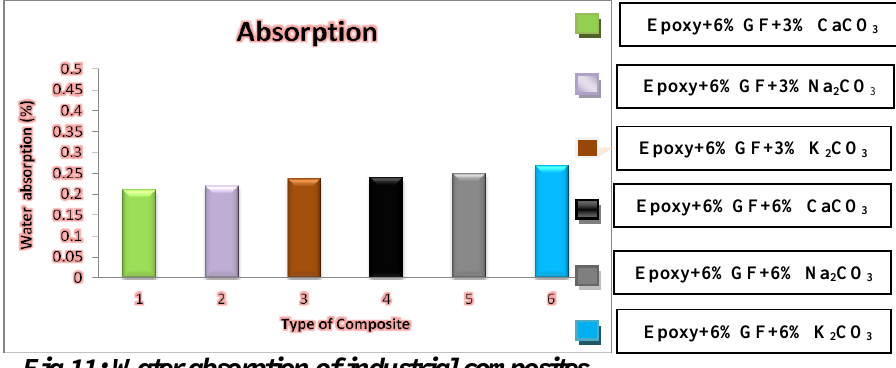
Fig.11: Water absorption of industrial composites .